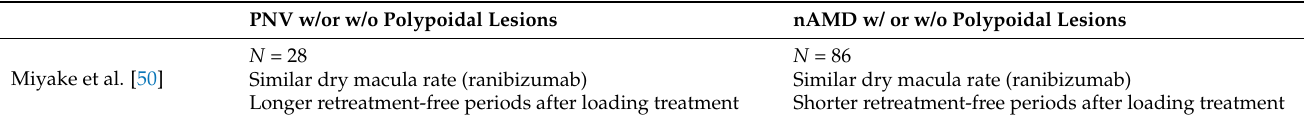
Table 8. Treatment response of PNV with or without polypoidal lesions and nAMD with or without polypoidal